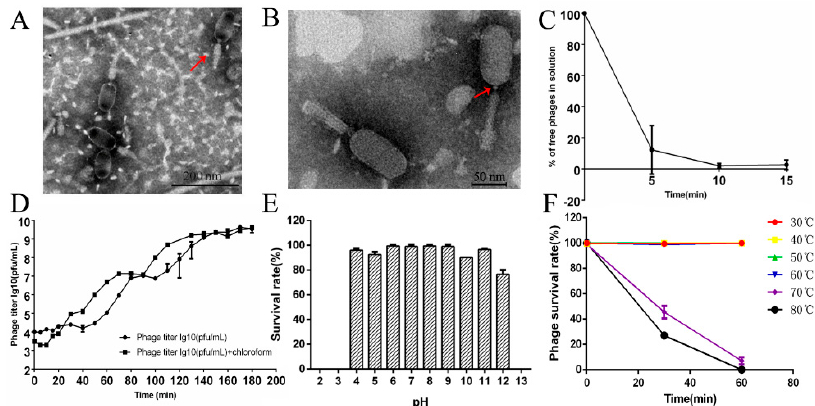
Figure 2. Morphology and biochemical characterization of LPSEYT. ( A,B ) TEM analysis of LPSEYT.